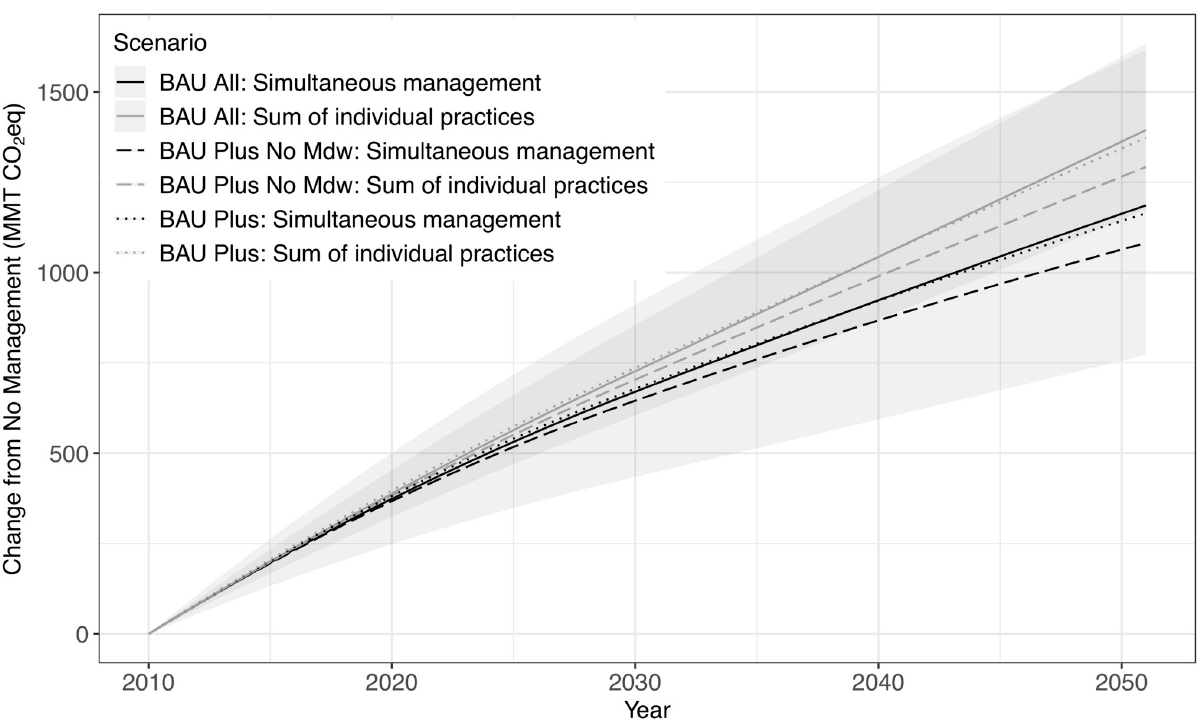
Fig 9. Cumulative emissions of three BAU management scenarios with respect to no management. These are based on either the sum of individual practice simulations or a single simulation that applies the practices simultaneously. Shading represents uncertainty for each of the two BAU All scenarios. BAU Plus No Mdw = BAU Plus No Meadow. See Table 3 for scenario